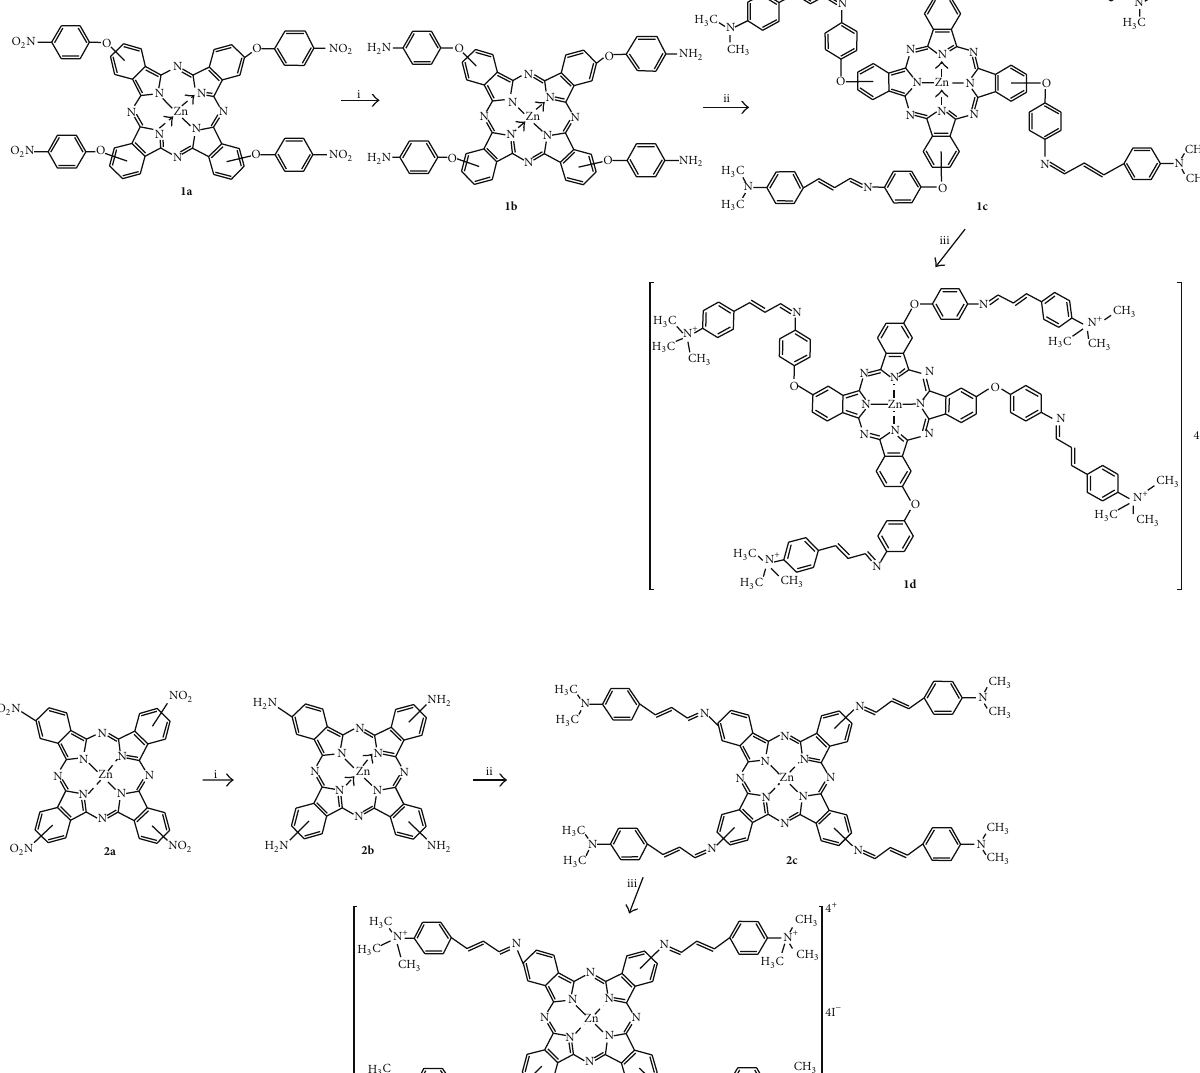
THF > DMF > DMSO except 2d in DMSO,